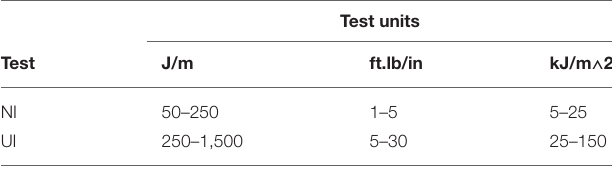
TABLE 1 | Typical range of impact performance of GF-PP composites (from injection molded short fiber, through molded long fiber, to compression molded GMT) in the different units used in different standard pendulum impact